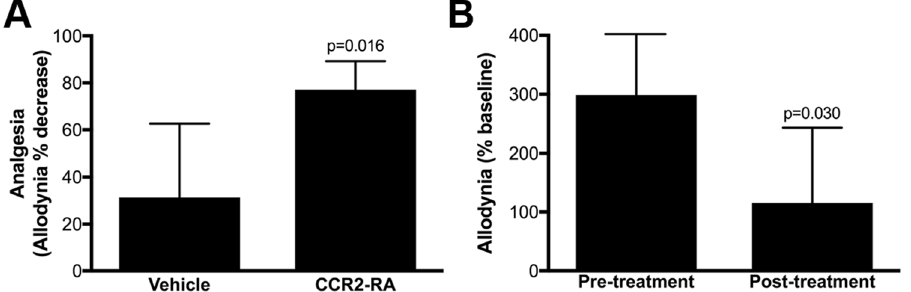
Figure 5. CCR2 mediates post-UTI chronic pain. Values represent mean ± S.D. ( A ) Female B6 mice were infected with E. coli strain S Φ 874. On PID 16, mice received i.p. injection of 10 mg/kg CCR2-RA or vehicle (n = 5 each group). Mice receiving CCR2-RA exhibited significantly decreased allodynia ( * P < 0.05). ( B ) Mice were infected with UPEC strain NU23 (n = 8). On PID 14, female B6 mice were evaluated for allodynia relative to baseline. Mice were then re-evaluated after administration of 20 mg/kg CCR2-RA. CCR2-RA significantly reduced allodynia induced by NU23 ( * P <